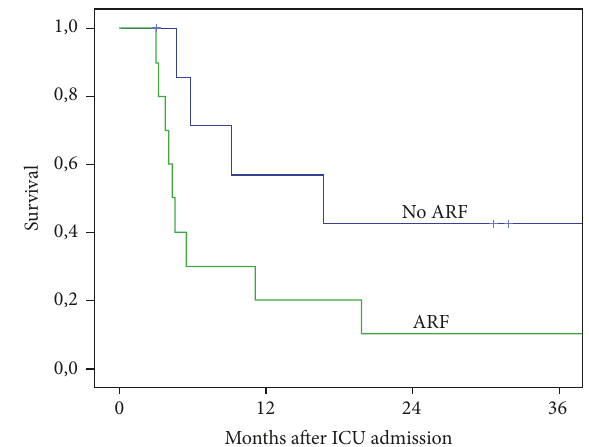
Figure 3: Survival of the patients related to the need of renal replacement therapy (ARF: acute renal